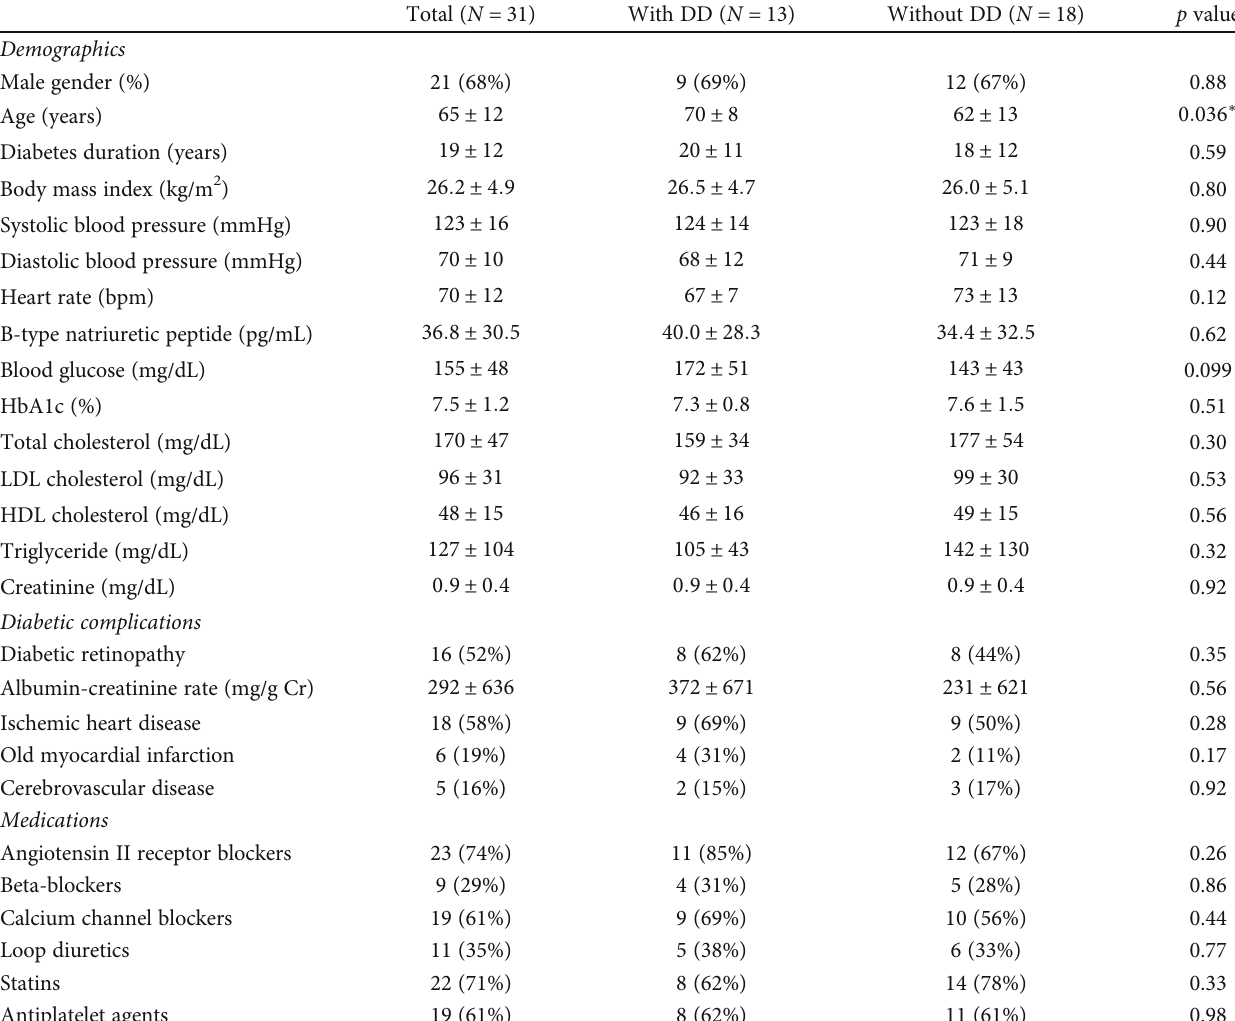
Table 1: Patient baseline